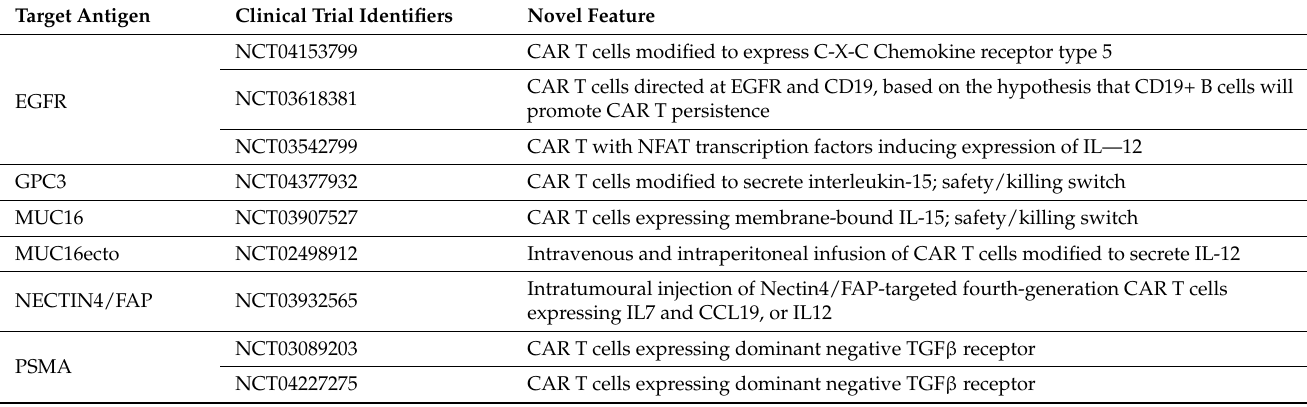
Table 2. Selected CAR T cell trials in solid cancers exploring novel